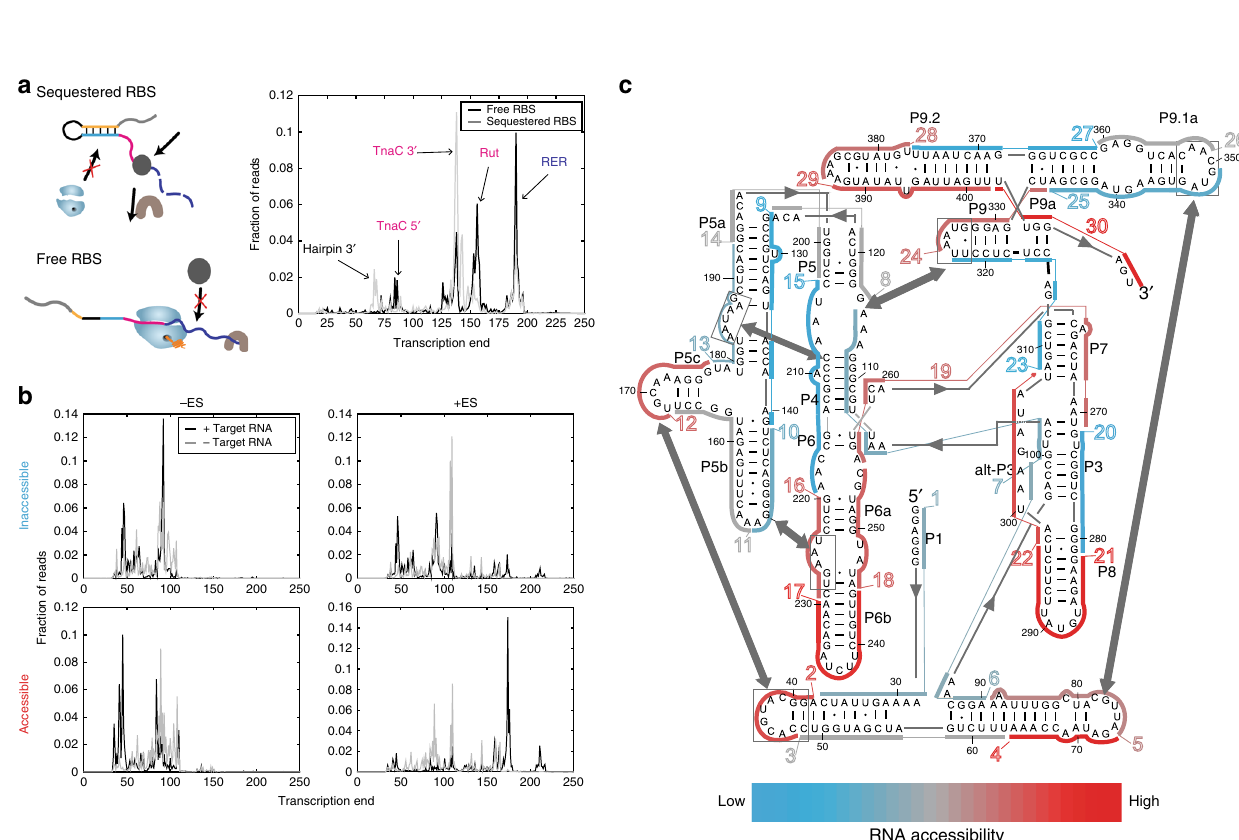
Fig. 1 Elements, utility, and complete protocol of INTERFACE. a Moving from 5 ′ to 3 ′ , each INTERFACE is composed of a unique asRNA probe, followed by the RSE, then the ES, comprised of tnaC and the rut site, and then the RER (a truncated gfp gene). INTERFACE can adopt two distinct RNA conformations depending on asRNA probe:taRNA region binding that determines the exposure of the RBS upstream of the ES: (i) a structured hairpin in which the RBS is occluded and (ii) an unstructured domain in which the RBS is exposed. b When targeting an accessible region (left panel), the INTERFACE asRNA probe ‘ X ’ binds strongly, releasing the RBS for tnaC translation. Translation of tnaC causes ribosomal stalling near the rut . The stalled ribosome physically occludes the Rho factor from the rut site which enables transcriptional elongation. In contrast, INTERFACE targeting of an inaccessible RNA region with asRNA probe ‘ Y ’ (right panel) generates a truncated transcript. Speci fi cally, the absence of tnaC expression due to lack of binding between the asRNA probe and the taRNA enables rut site availability for Rho-dependent transcriptional termination. c ( i ) A library of asRNA probes is inserted into either of two parent plasmids (Supplementary Fig. 1). ( ii ) The library is transformed into the relevant experimental strain as described in Methods section. ( iii ) The INTERFACE system is induced and the library of asRNA probes interact with corresponding taRNA regions in vivo to varying degrees, generating a spectrum of transcript lengths bar-coded with the probe sequence at the 5 ′ -end. ( iv ) Total RNA, including transcripts of interest containing corresponding probes (green and orange 5 ′ -ends circled in red), is extracted. ( v ) A cDNA library for Illumina-platform RNA-seq is generated, in which INTERFACE RNA is among the pool of adapter-ligated RNA and consequently in the fi nal cDNA library (red). ( vi ) RNA-seq is performed per standard procedures in a paired-end 75 × 2 run in the Illumina platform. ( vii ) Mapping against synthetic INTERFACE library is performed to exclude non-INTERFACE transcripts and associate corresponding 3 ′ -ends (R2) to 5 ′ -ends (R1) to determine the length of each region-speci fi c